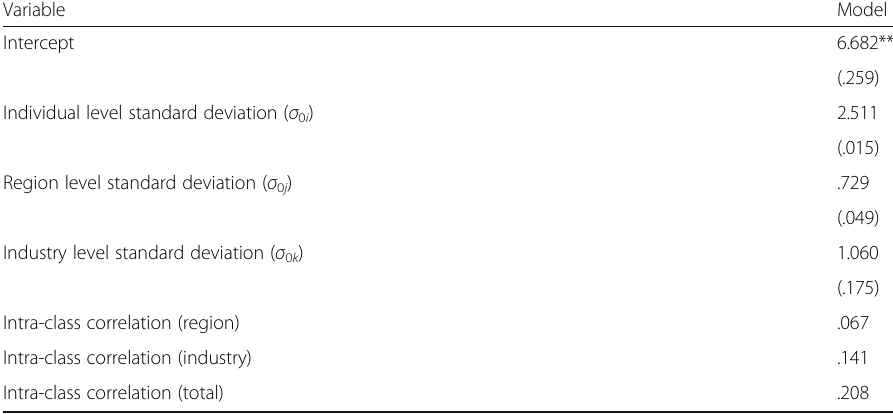
Table 2 Variance components model for individual monthly income (Log),